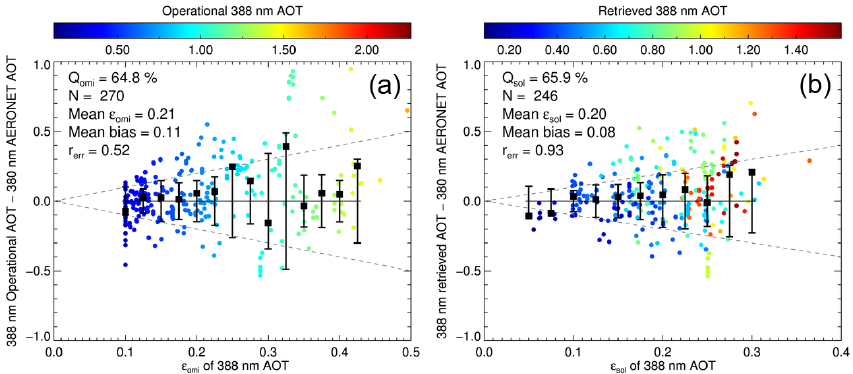
Figure 8. Comparison between estimated uncertainties of the 388nm AOT ( x axis) and biases of retrieved AOT from AERONET measure- ments ( y axis). The panels (a) and (b) are based on the operational and OE-based retrieval/error-estimation algorithm, respectively. Table 5. Error sources and their assumed magnitudes in the OMI ATBD (Algorithm Theoretical Basis Documents) and this study. Error source Error perturbation Assumed value of σ for each (OMI